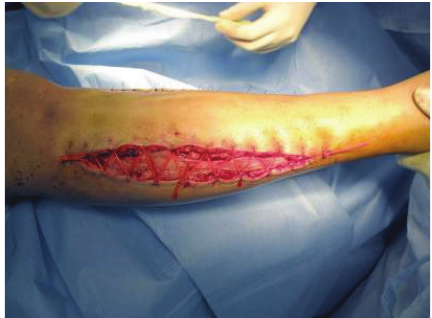
Figure 7: Anatomical section view of the forefoot. The dorsal approach uses one or two longitudinal incisions. It facilitates access to the interosseus and adductor compartments. MT = metatarsal; M = medial compartment; A = adductor compartment; S = superfi- cial compartment; L = lateral compartment.